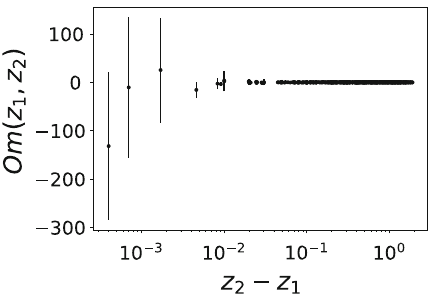
Fig. 3 This plot shows the theoretical curves for the best-fit (cid:2) CDM and R h = ct models, along with the data for Om ( z 1 , z 2 ) (grey points). For this plot, four H ( z ) points with the largest error bars have been removed for which the value of Om ( z 1 , z 2 ) was large. Since this plot is for illustrative purposes, we have also removed the error bars in the Om ( z 1 , z 2 ) valuesforbrevity.Theactualerrorbarsaremuchlargerthan the differences between the two models. Therefore, it is not possible to distinguish between the two models using Om ( z 1 , z 2 ) measurements few other works [36,38,39,41] also found that type 1a